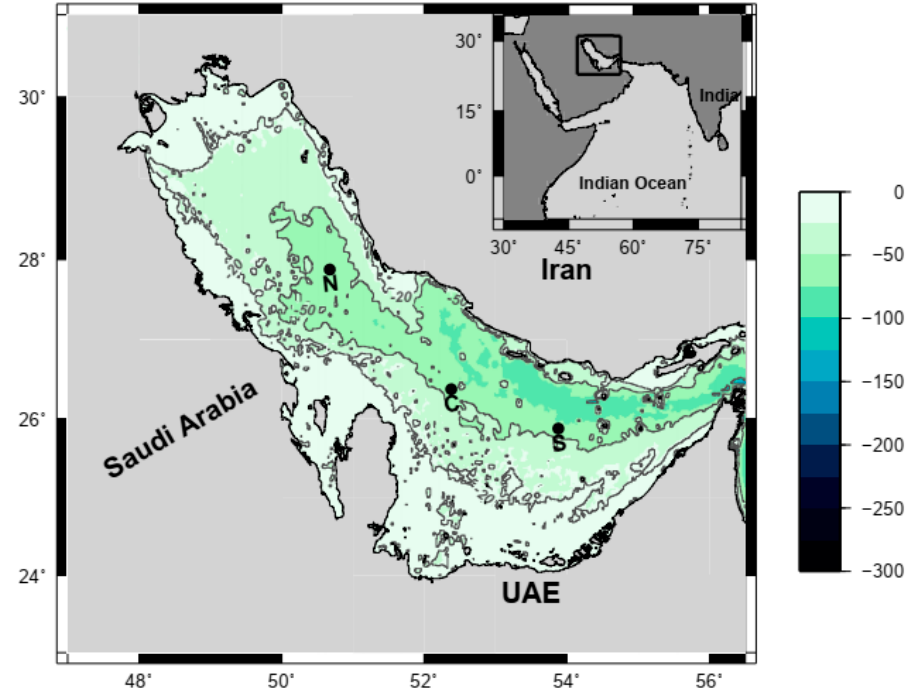
Figure 1. Map of the Arabian Gulf with Bathemtry. The black dots represent locations of temperature depth profiles for the northen (N), central (C), and southern (S) parts.